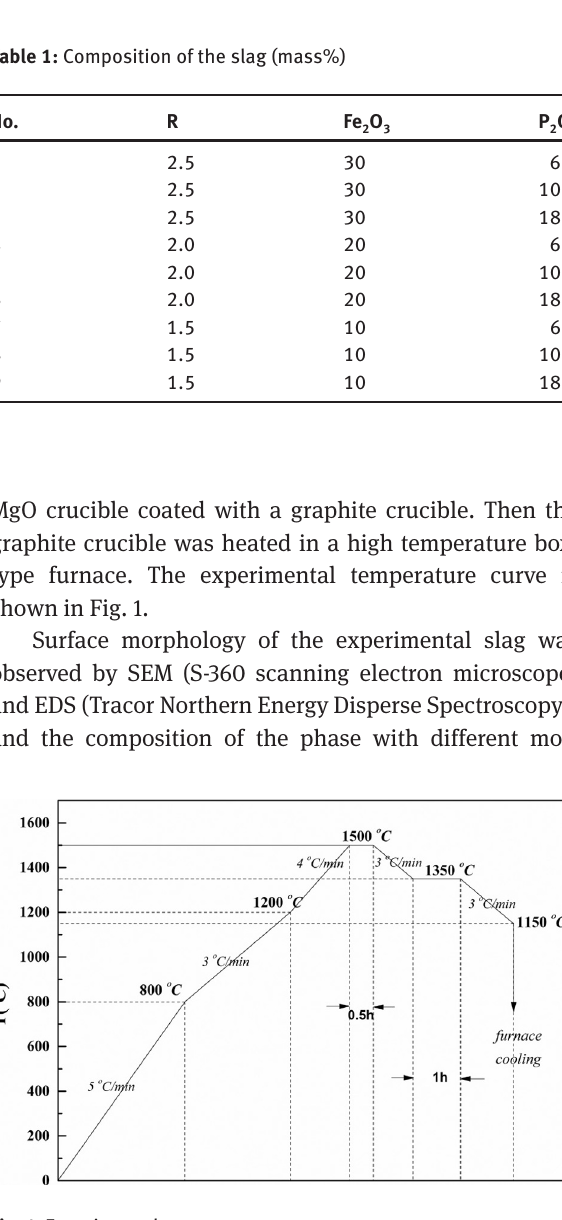
Fig. 1: Experimental temperature curve